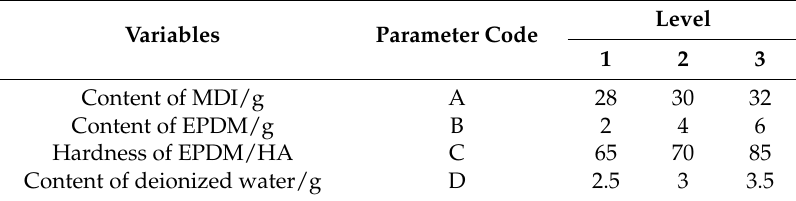
Table 2. Design variables and their levels.